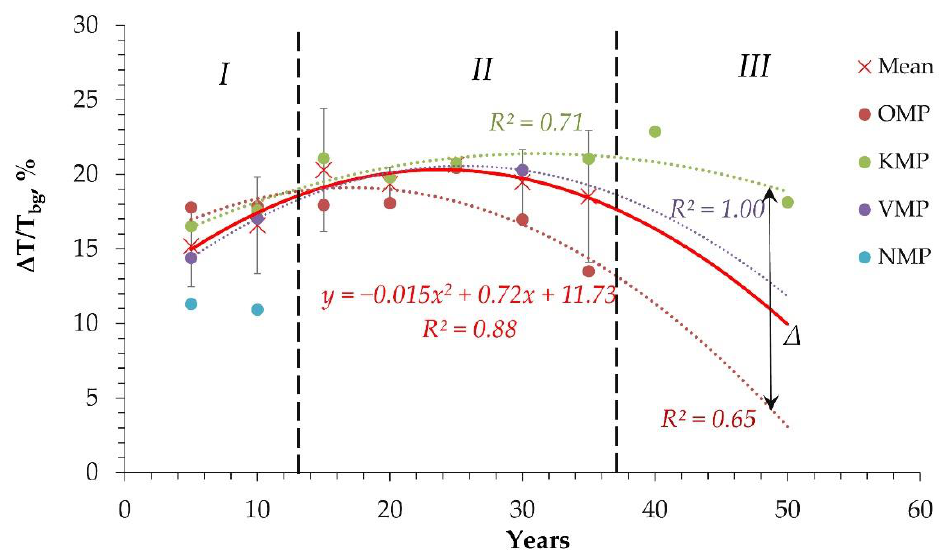
Figure 3. Thermal anomalies in disturbed areas of selected technogenic plots: ( × ) average for all areas. (OMP) Olimpiada, (KMP) Kuranakh, (VMP) Verninskoye, (NMP) Natalka. Initial stage of technogenic impact (I), the stage of technogenic activity (II), and post-technogenic recovery stage (III) have been marked out.